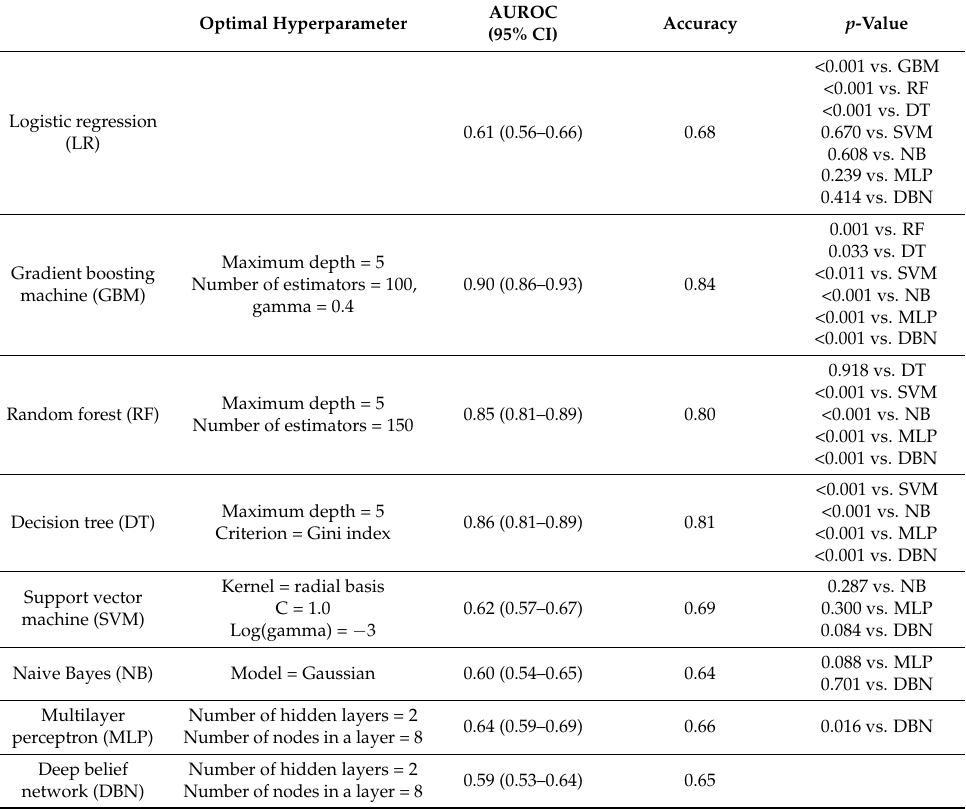
Table 2. Comparison of area under receiver-operating characteristic curve among the different models to predict acute kidney injury of all